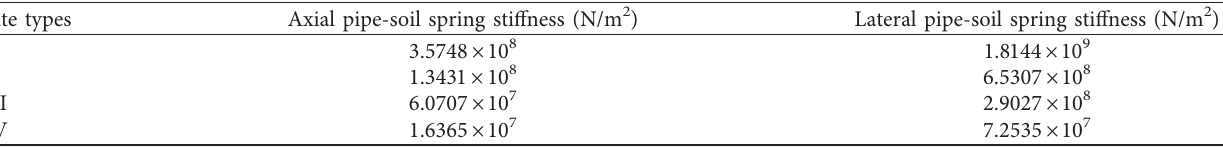
Table 3: Axial and lateral pipe-soil spring stiffness in the four sites.